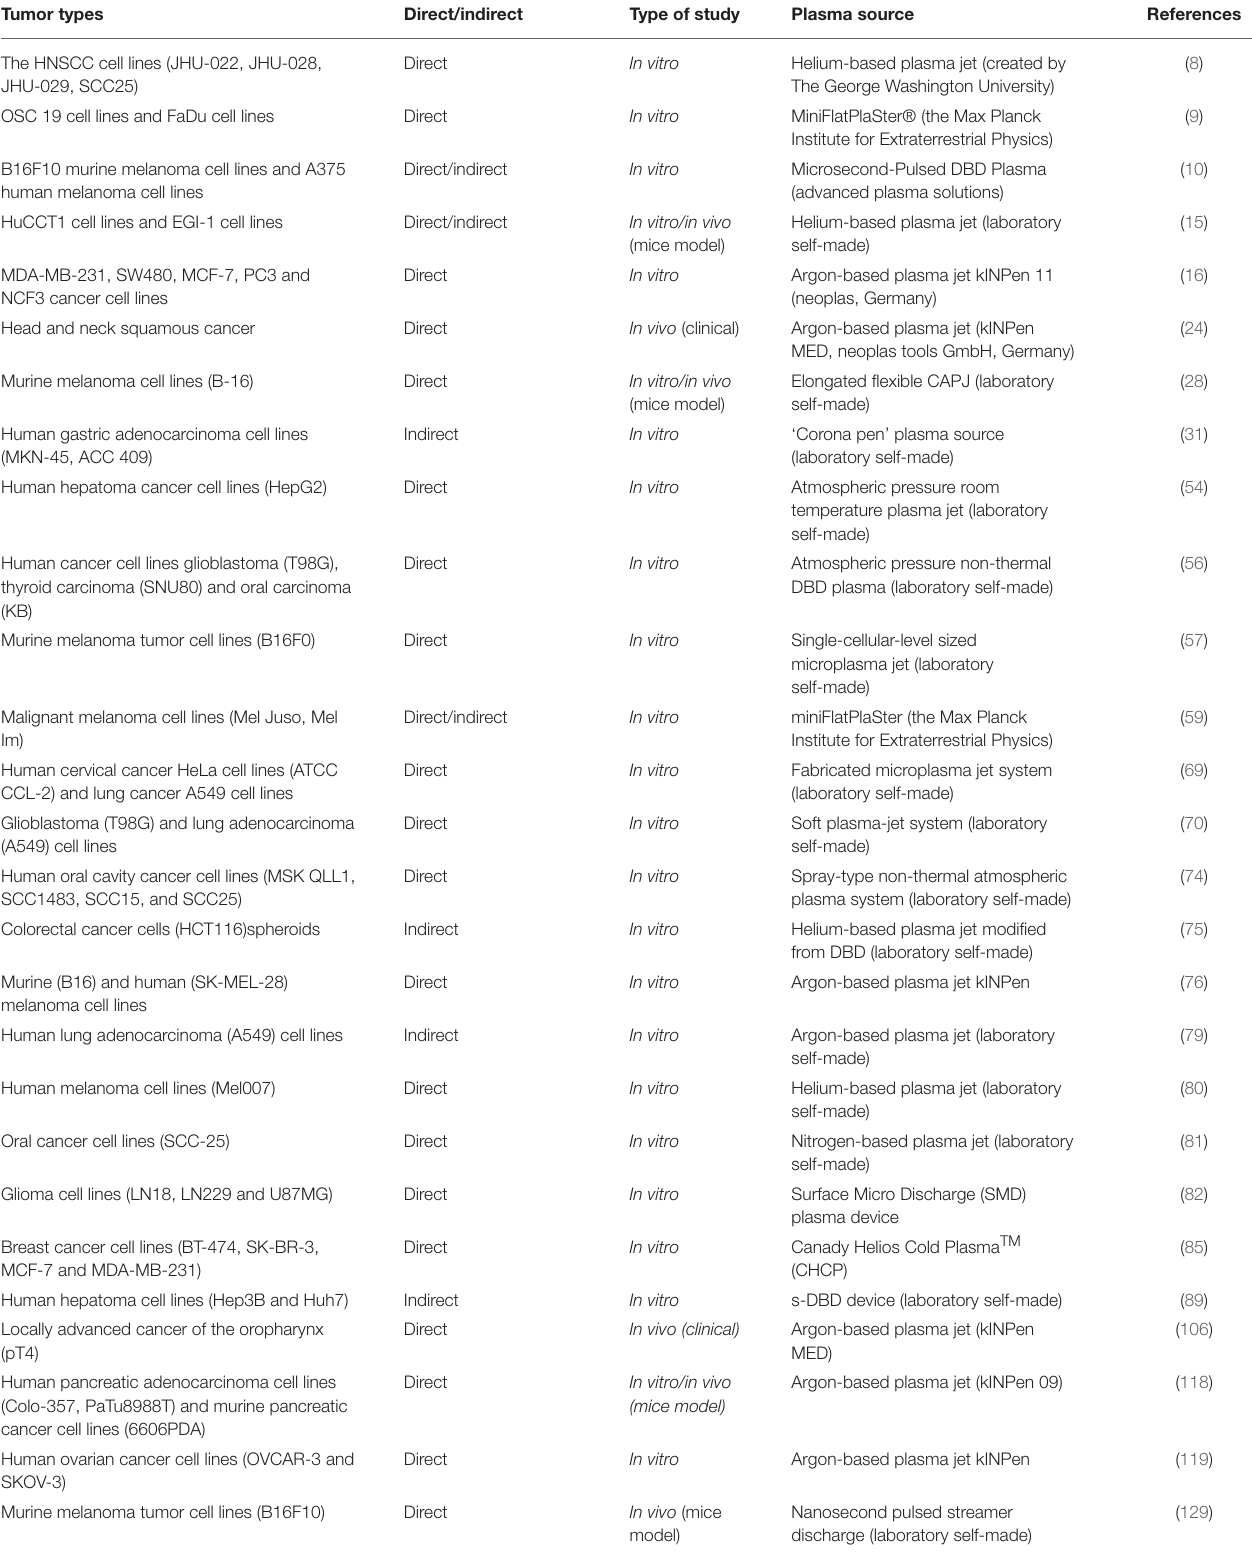
TABLE 1 | The studies of CAP in the treatment of tumors mentioned in the review. Tumor